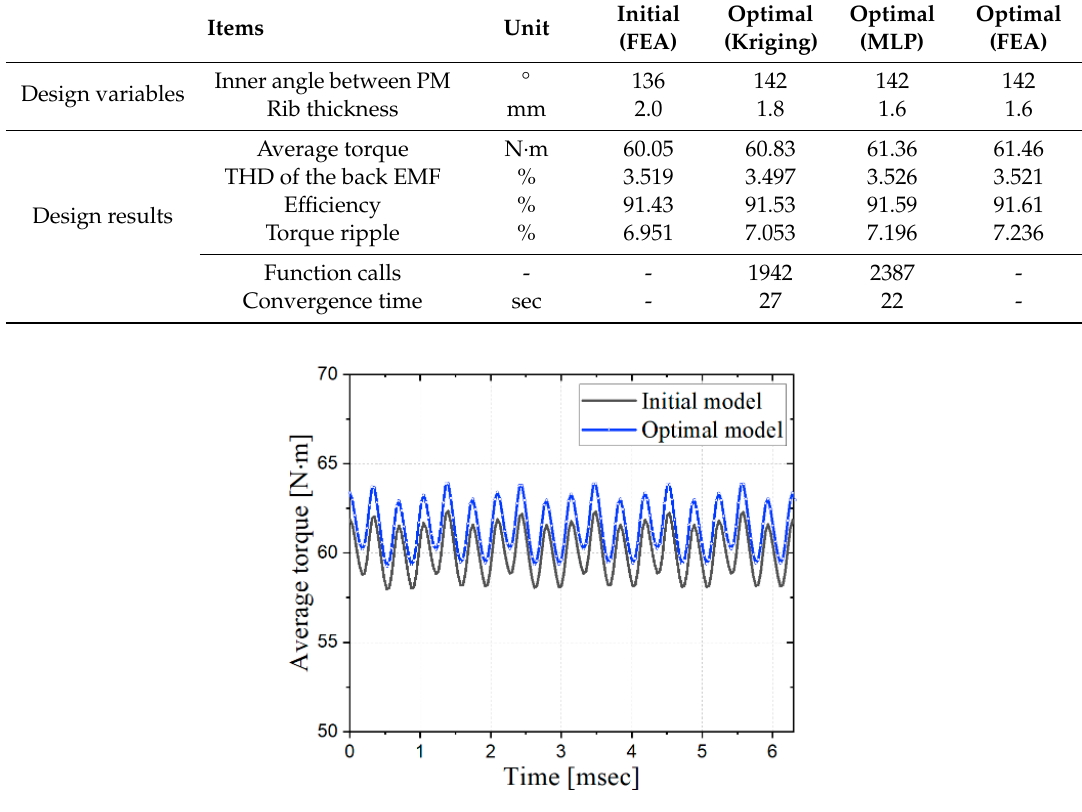
Figure 9. Torque waveforms.